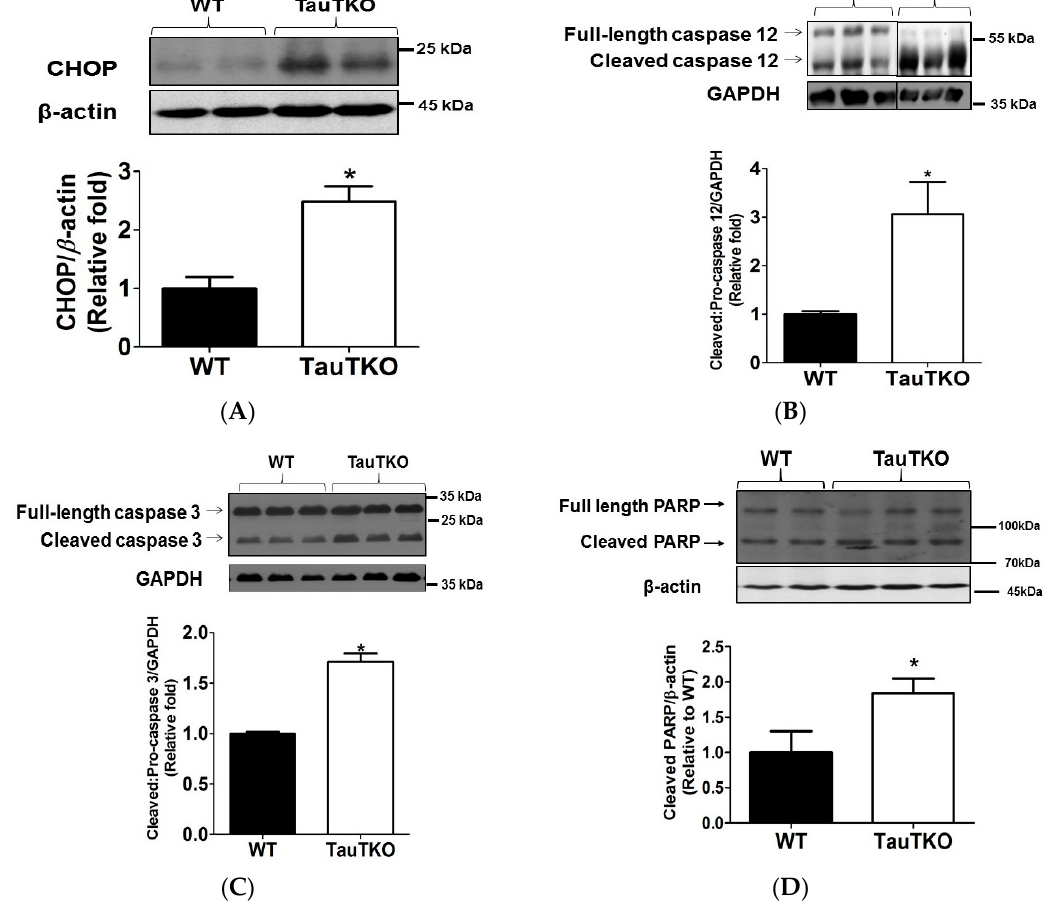
Figure 7. CHOP and UPR caspase cascade are activated in older TauTKO hearts. Total heart lysates from 12-month-old TauTKO and WT mouse hearts were subjected to western blot analysis of ( A ) CHOP, ( B ) caspase 12, ( C ) caspase 3 and ( D ) PARP. Each panel contains a representative gel and summation data expressed as means ± SEM of 6–9 hearts. The representative bands for WT and TauTKO shown in B were spliced from one original gel and the splice junction is indicated by the black splicing line. All values are expressed relative to WT, where WT is fixed at 1.0. * p < 0.05.